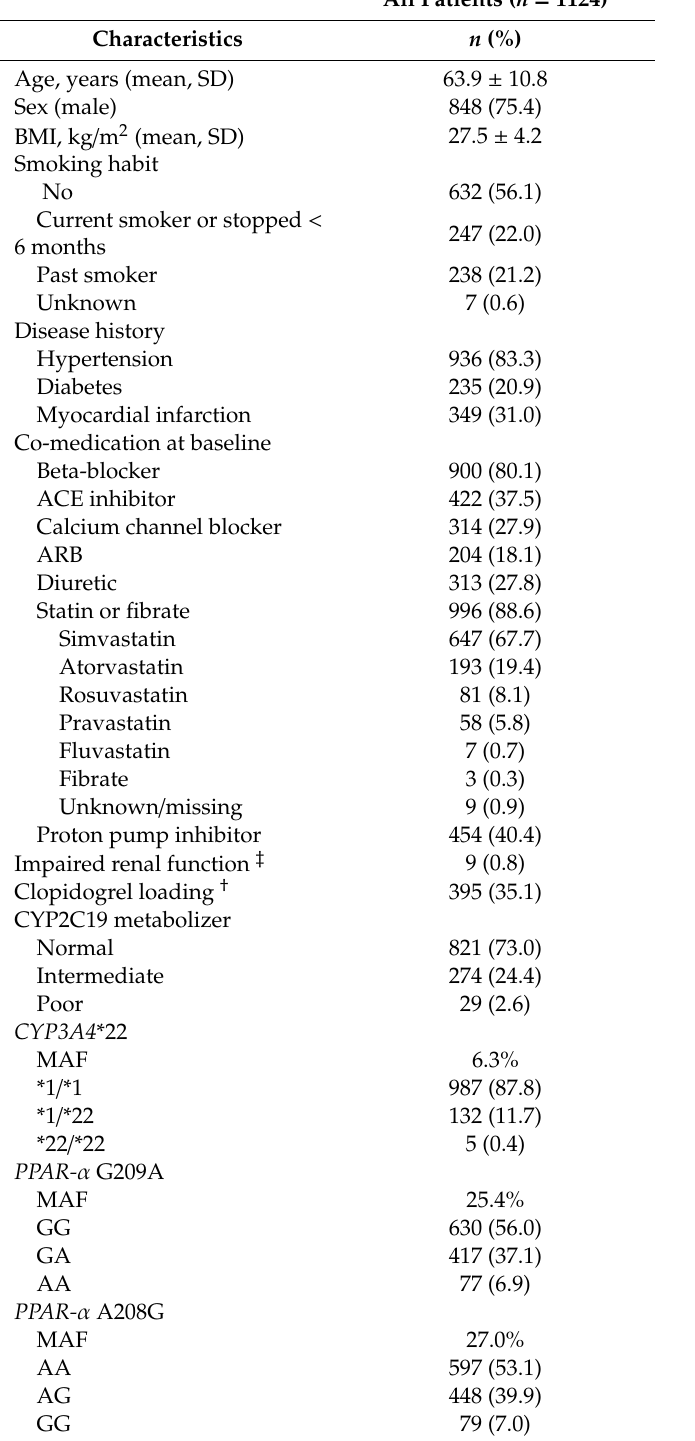
Table 1. Baseline characteristics. All Patients ( n =